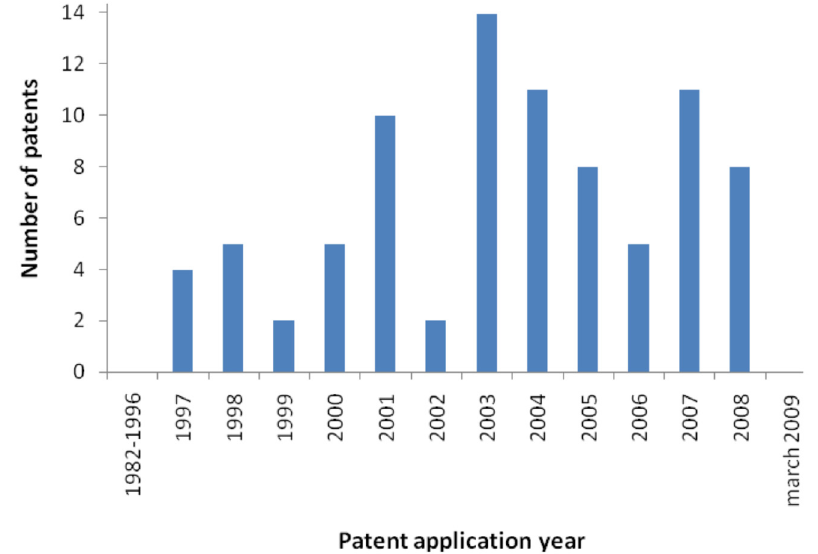
FIGURE 2 - Evolution of herbal extracts patenting for cosmetic application in INPI in the period 1982-2009. TABLE I - Major companies with patents registered in INPI Company